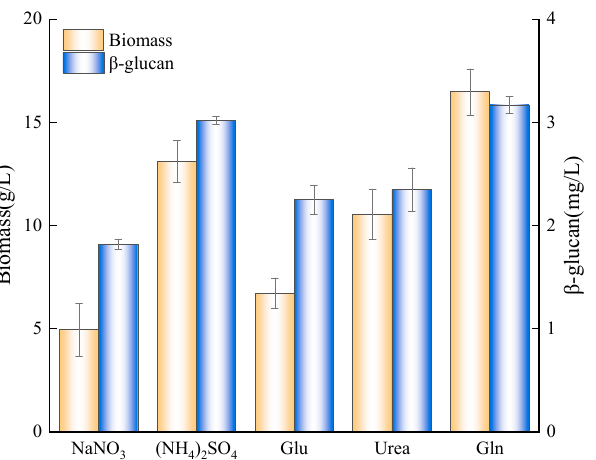
Figure 3. Effects of different nitrogen sources on A. pullulans ’s biomass and β -glucan yield.